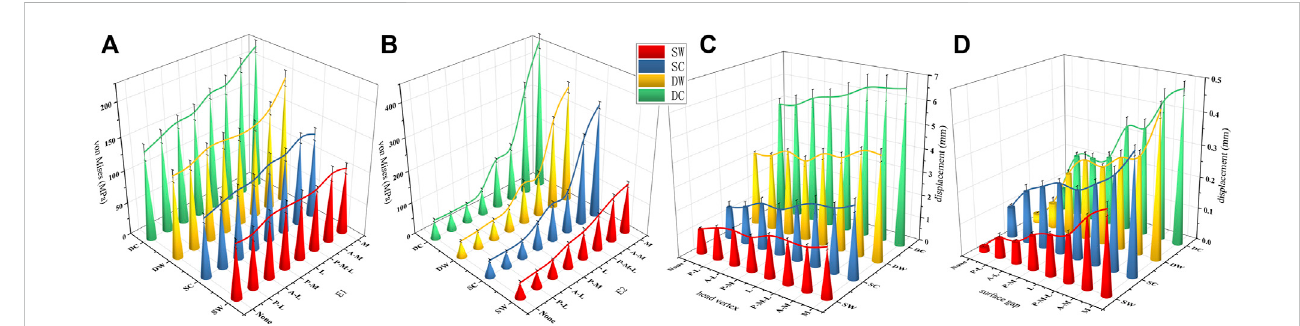
FIGURE 6 The von Mises stress curves of the IM nails (E1) and the helical blades (E2) were exhibited in (A,B) , respectively. The head vertex displacement and the surface gapswereexhibitedin (C,D) ,respectively. SW, SC, DW, andDC indicated thestatic walking, thestatic climbing,thedynamicwalking, and thedynamic climbing, respectively. None indicated the basic fracture model while the others indicated the same as mentioned above.